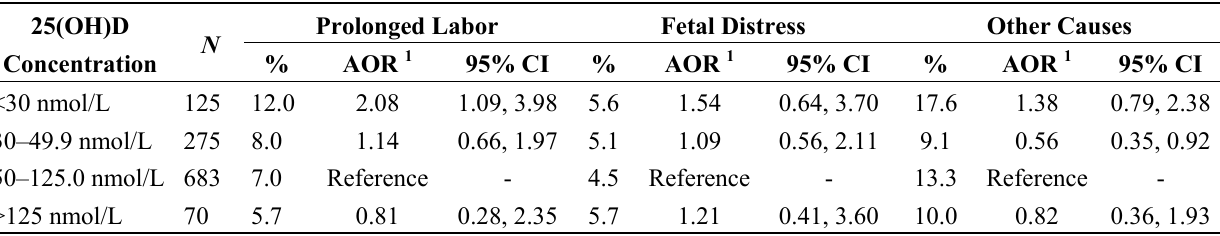
Table 4. Maternal 25(OH) D and total cesarean by